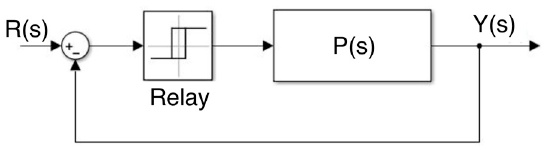
Figure 2. Relay experiment.